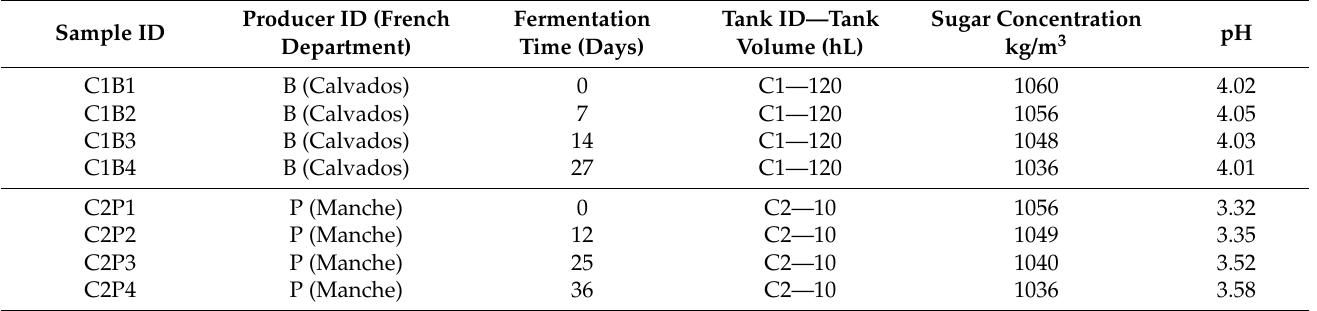
Table 1. Cider samples collected for the study of the phageome and for the prophage